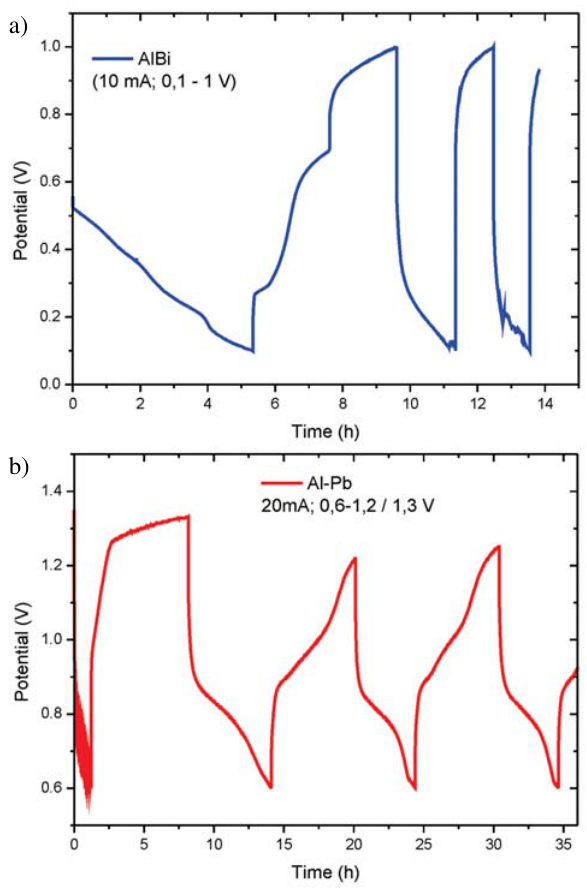
Figure 4. Galvanostatic measurement of (a) Al-Bi in electrolyte A; the constant current value was 10 mA whereas the voltage window was from 0.1 to 1.0 V. (b) Al-Pb in electrolyte B; the constant cur- rent value was 20 mA whereas the voltage window was from 0.6 to 1.3 V or 1.2 V for the first and next cycles,